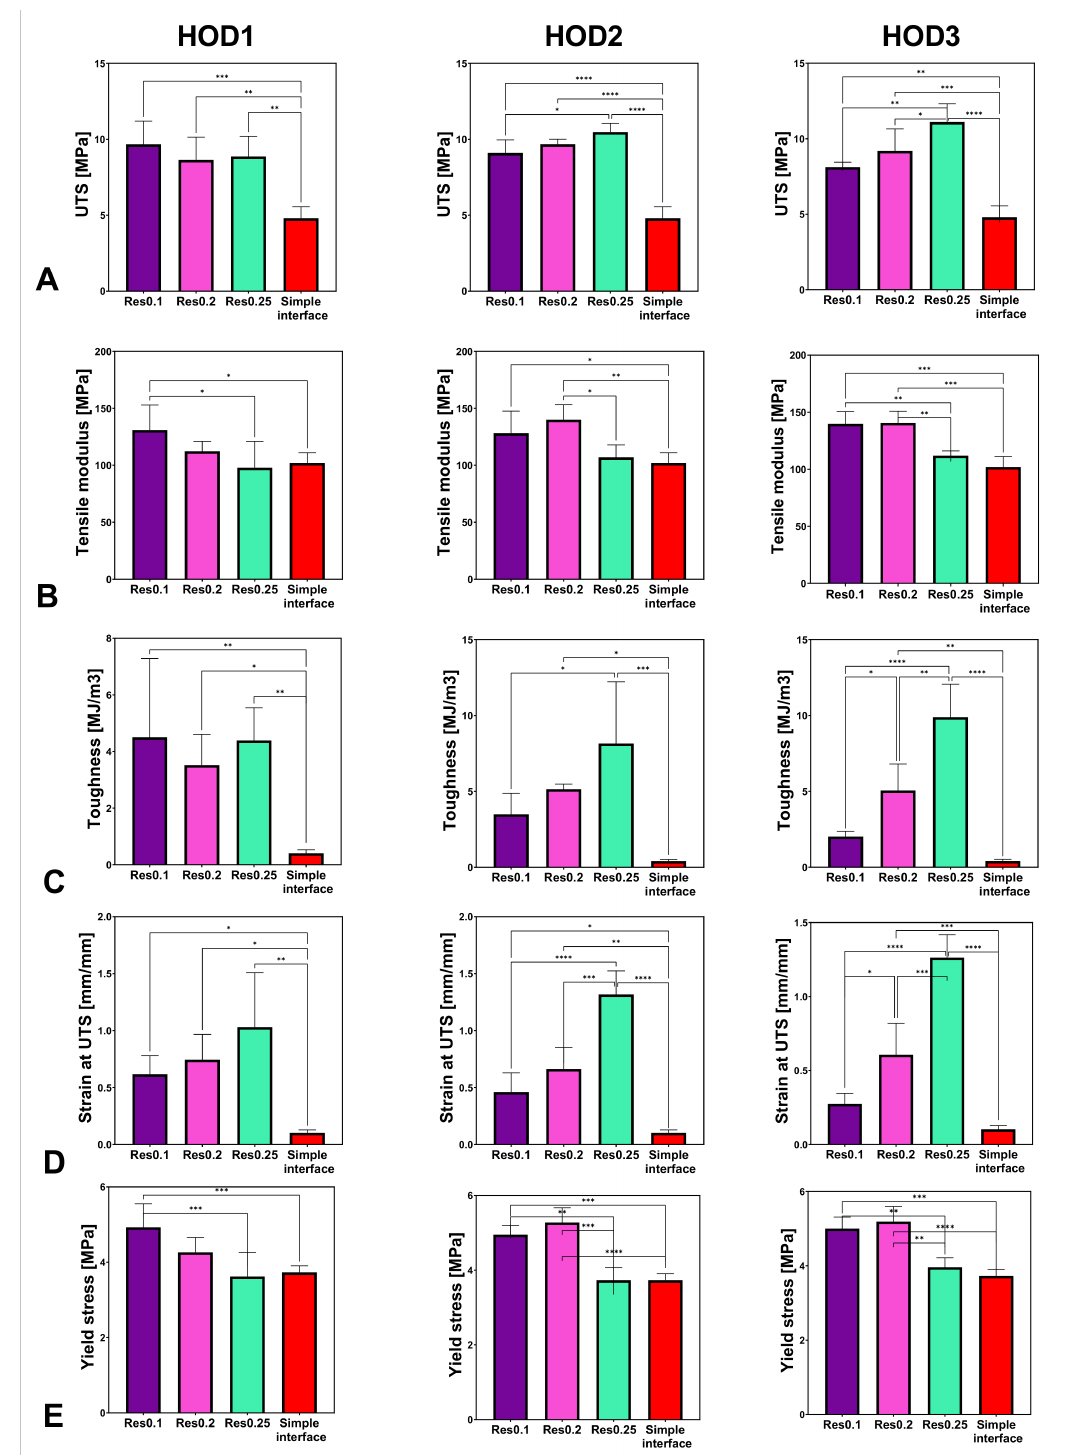
Figure 9. Effect of the resolution (RES) on the mechanical properties of stiff-to-compliant samples: ( A ) UTS; ( B ) tensile modulus; ( C ) tensile toughness; ( D ) strain at UTS; ( E ) yield stress (* stands for p < 0.05, ** for p < 0.005, *** p < 0.0005, and **** p <